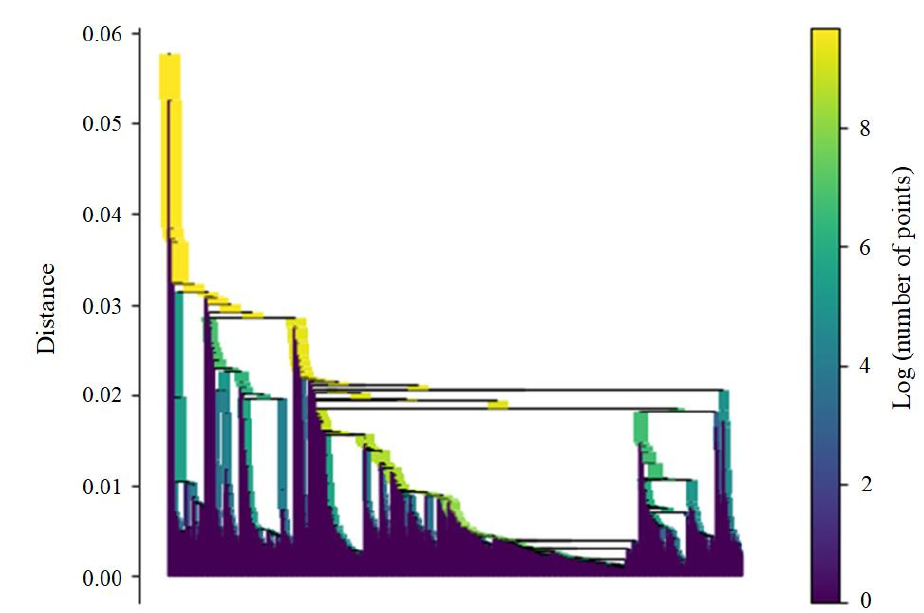
Figure 9. Single-link cluster hierarchy.